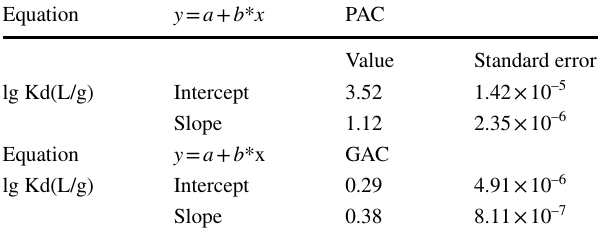
Table 3 Linear fit parameters derived from Fig. 2